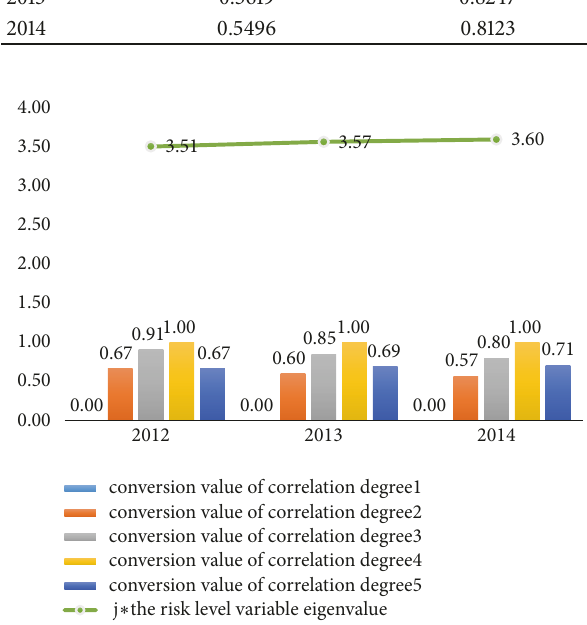
Figure 4: 2012 to 2014 deviated variable eigenvalues.